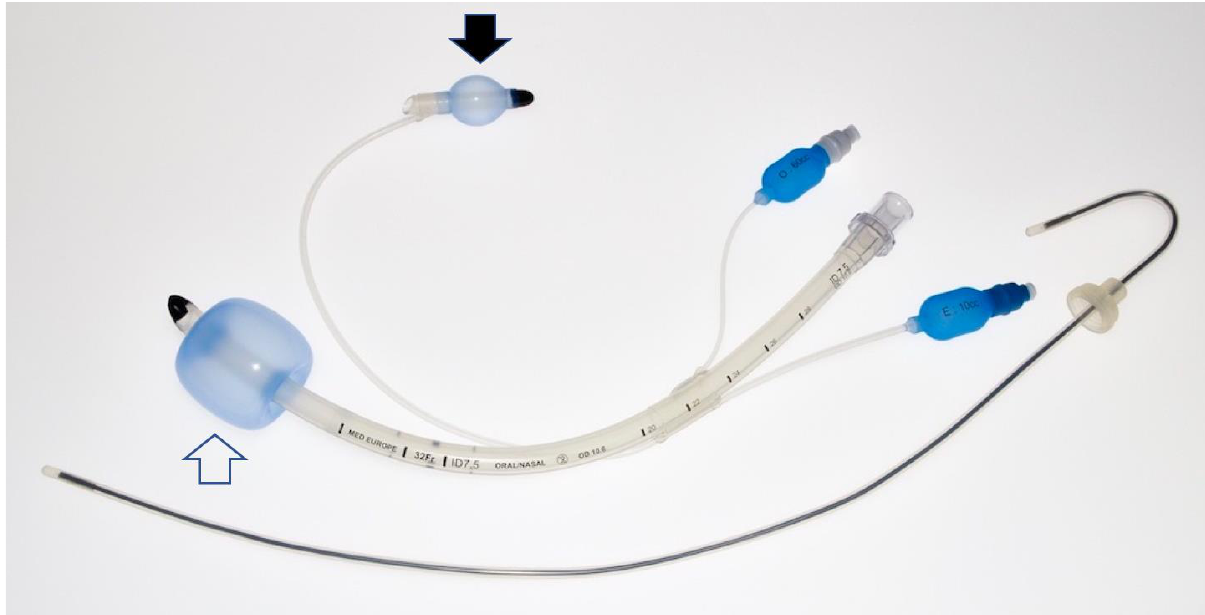
Figure 3. Spritztube details. The device assembled as if in definitive position; note the removed stylet. Once placed as extraglottic device, the distal (oesophageal) cuff (solid arrow) closes the upper oesophageal sphincter while the oropharyngeal cuff (empty arrow) seals the oropharynx. If intubation is performed, the proximal cuff is left inflated and in place, the oropharyngeal cuff deflated and the tube is addressed in trachea with direct view (flexible scope or video-stylet).